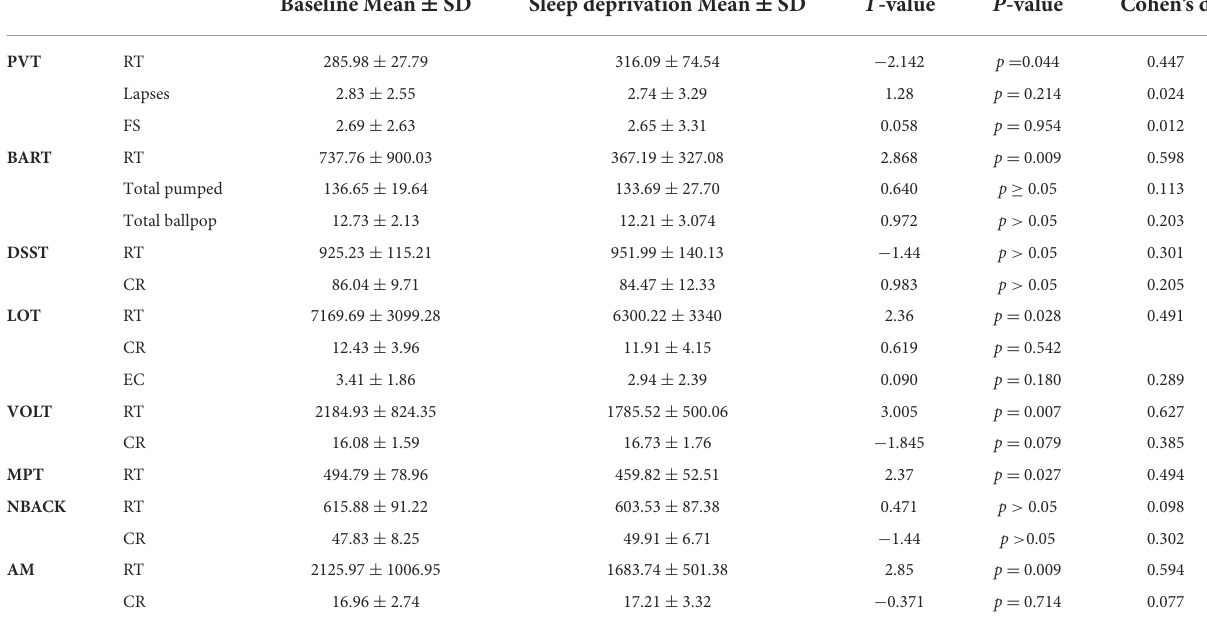
TABLE 1 Cognitive